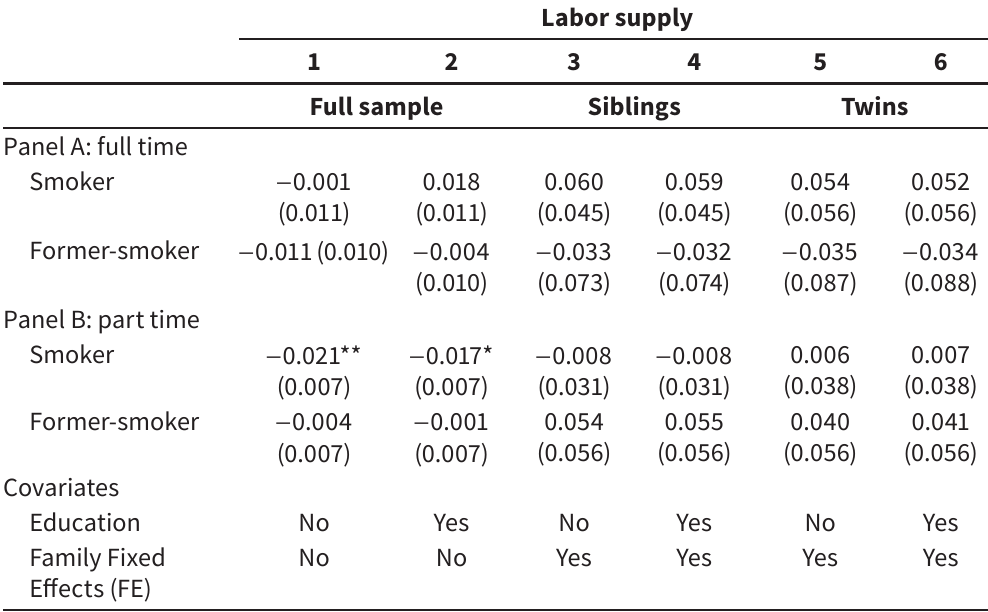
Does smoking or ever-smoking influence labor market